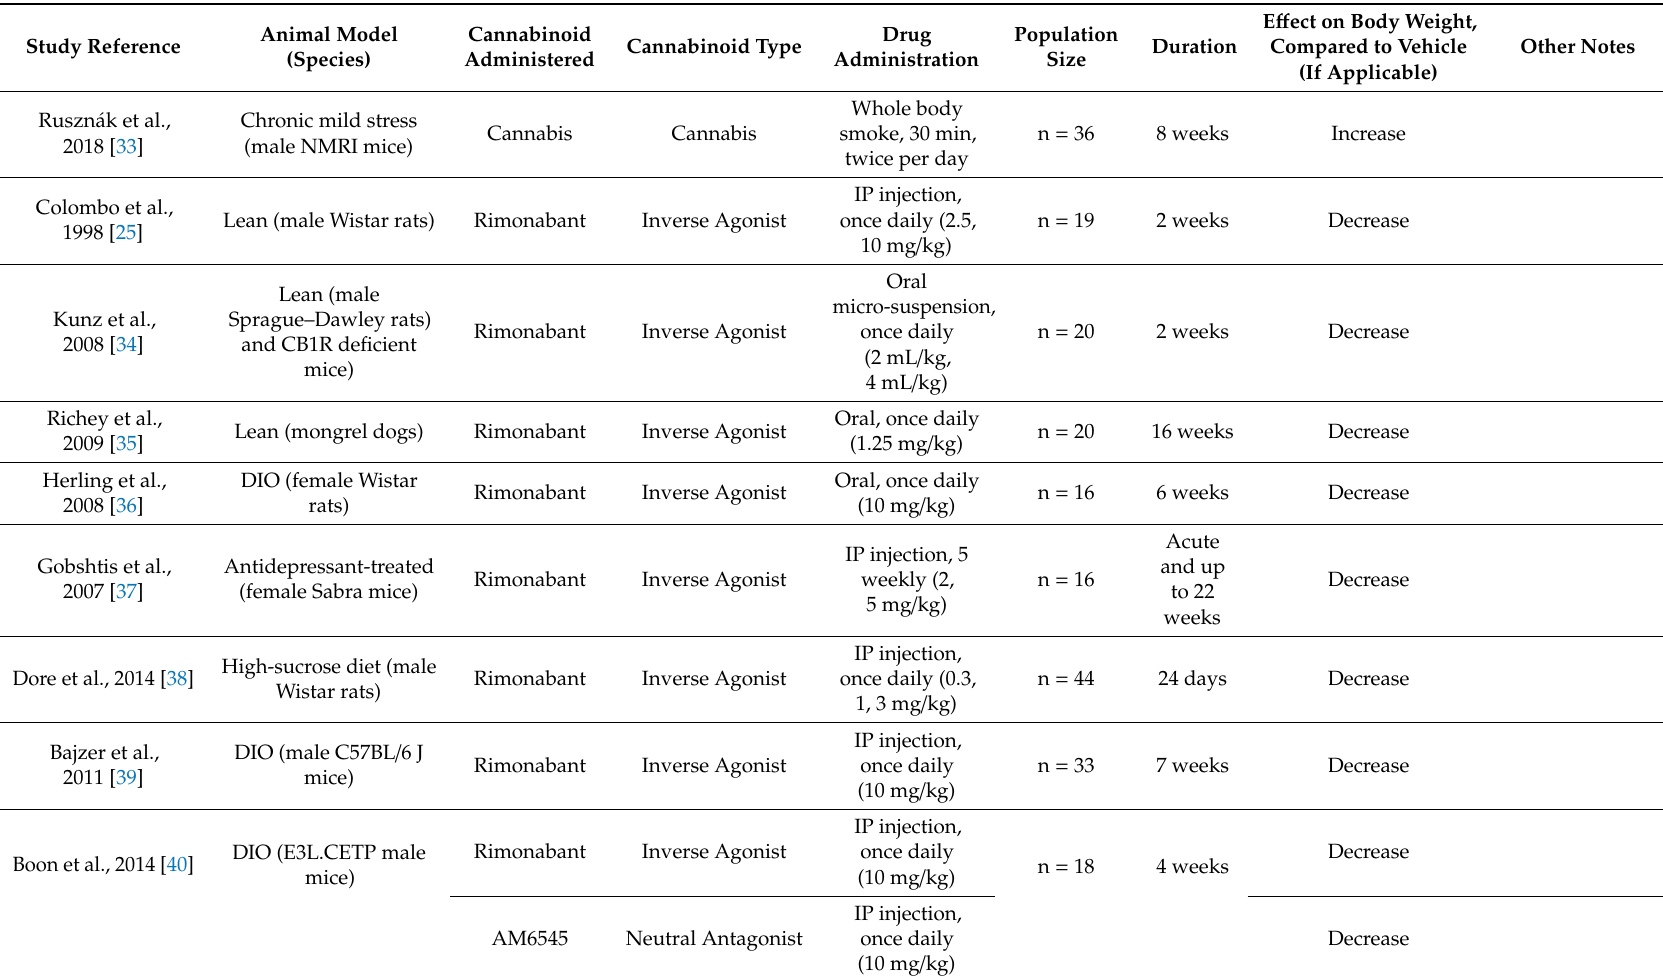
Table 1. Summary of Evidence: Preclinical Studies of Cannabinoid Drug E ff ect on Body